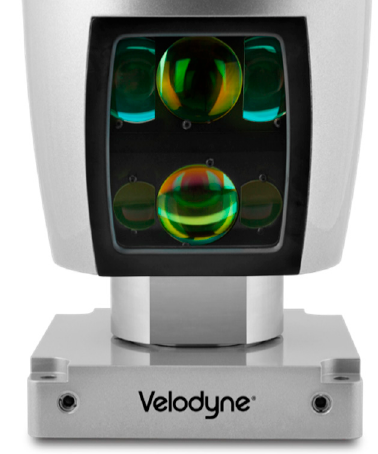
Figure 4. Velodyne HDL 64 lidar [99].